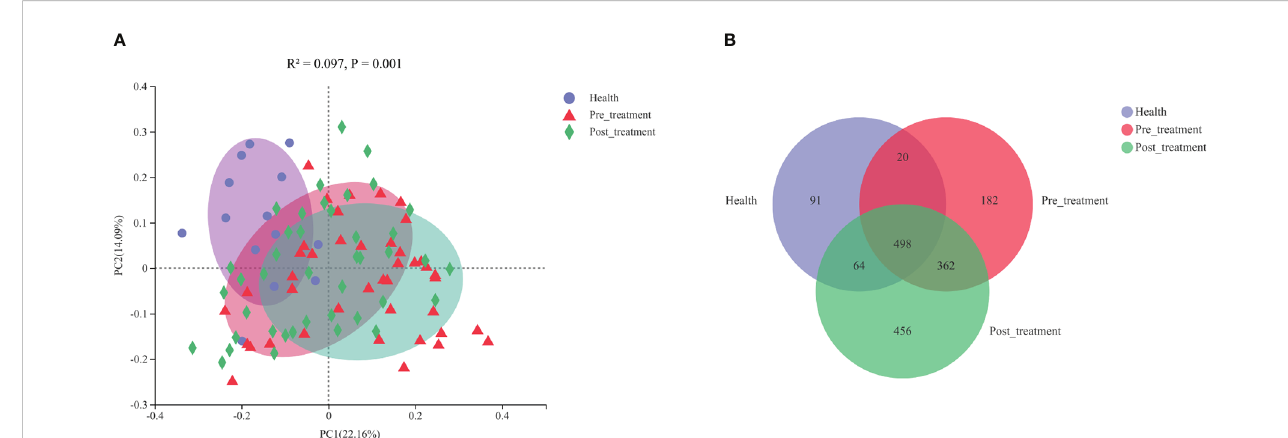
FIGURE 3 (A) Principal coordinated analysis (PCoA) plots constructed based on weighted Unifrac distances at the OTU level. (B) A venn diagram representing the shared and unique OTUs in the submucosal microbiomes of the healthy, pre-treatment, and post-treatment groups.